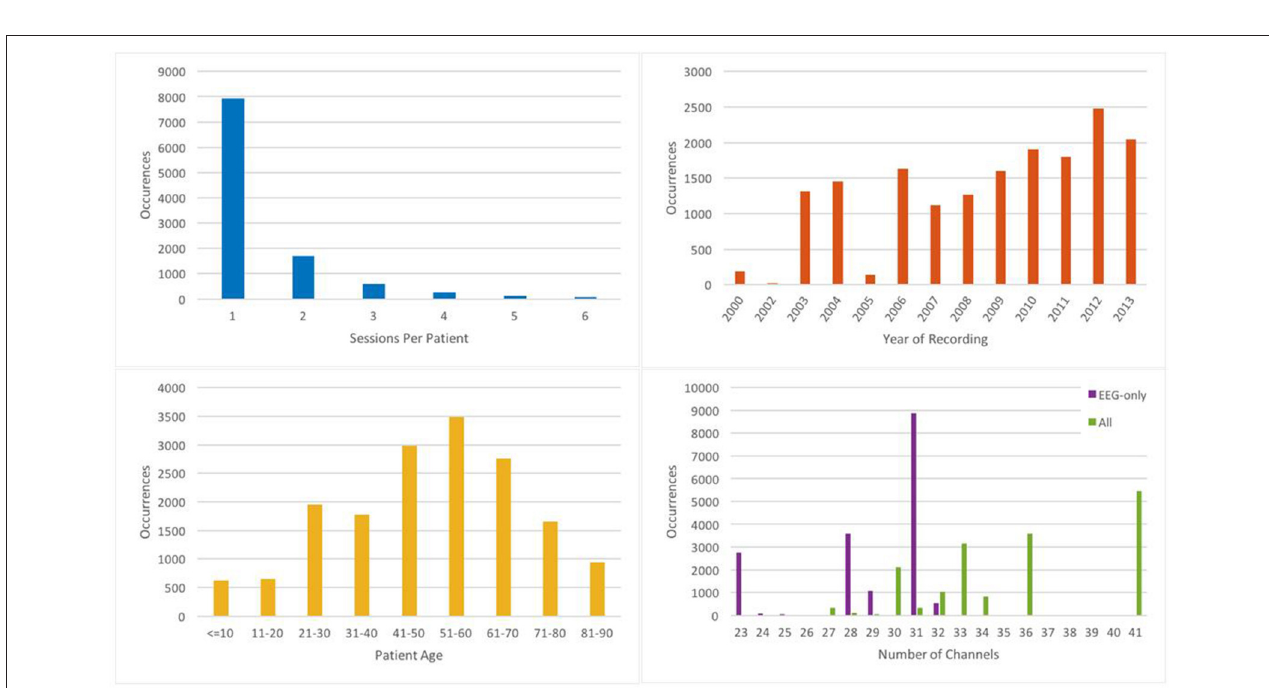
FIGURE 2 | Some relevant statistics demonstrating the variety of data in TUH-EEG.